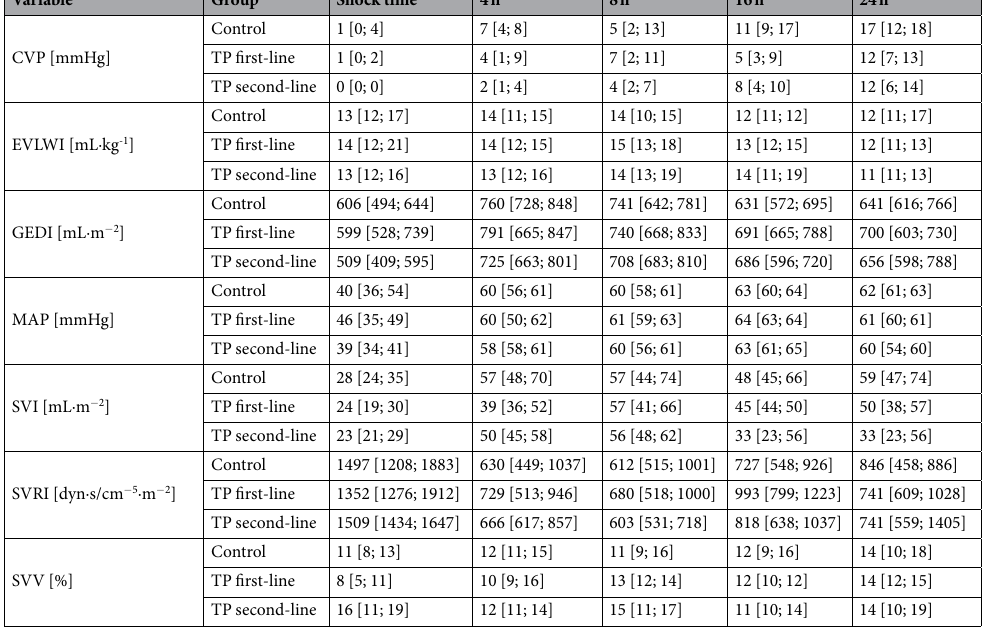
Table 1. Haemodynamics of the study groups during the 24-hour interventional period. Values are presented as median [interquartile range]. CVP, central venous pressure; EVLWI, extravascular lung water index; GEDI, global end-diastolic index; SVI, stroke volume index; SVRI, systemic vascular resistance index; SVV, stroke volume variation; TP, Terlipressin